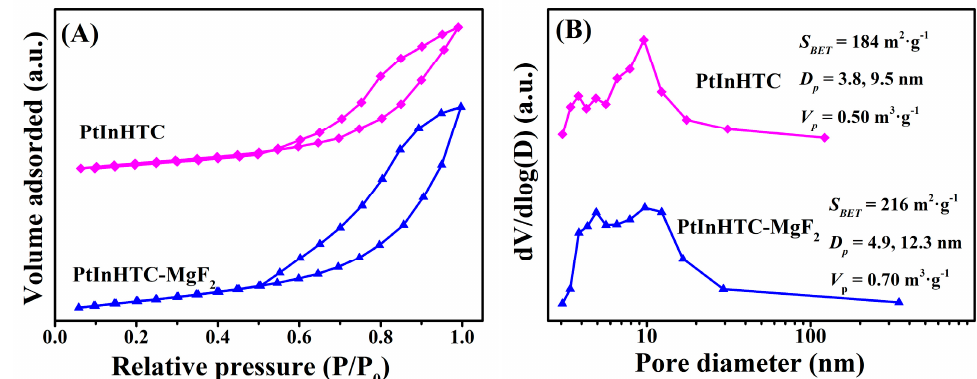
Figure 2. ( A ) Low temperature N 2 adsorption–desorption isotherms, ( B ) pore size distributions curves, and textural data of the calcined catalysts, involving BET special surface area (S BET ), the most probable pore size determined by the BJH method (D p ), and total pore volume (V p ).